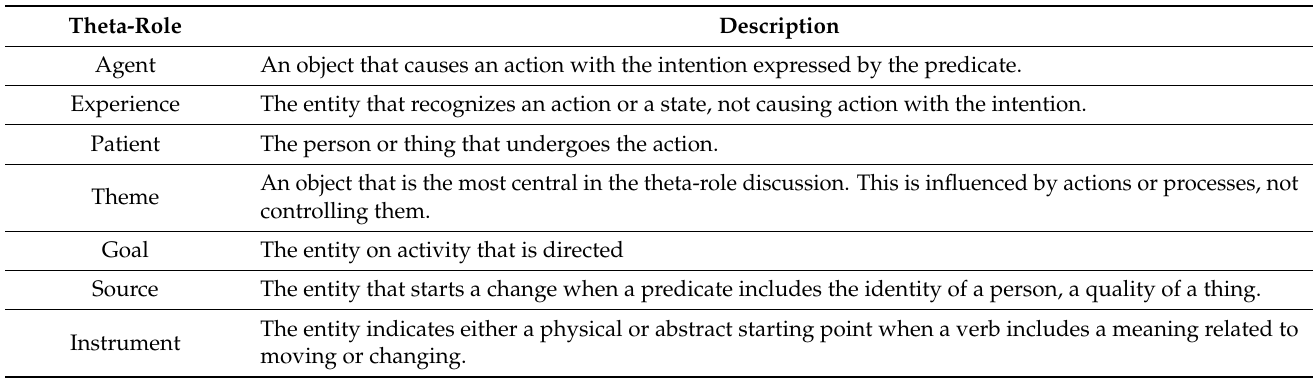
Table 4. Parts of Theta-role in Sejong’s Electronic Dictionary